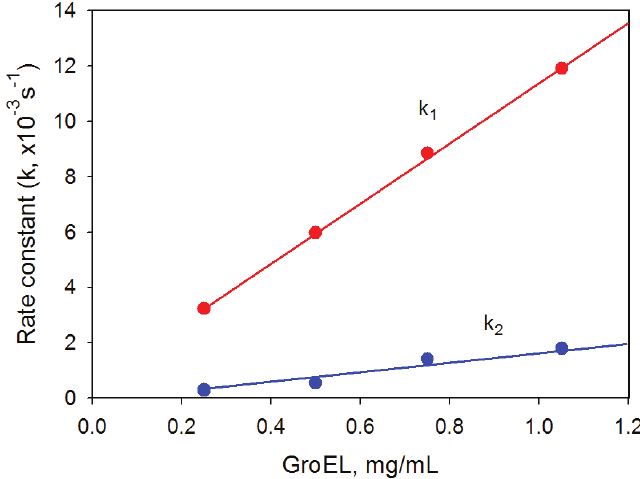
Figure 6. Dependence of the rate constants of GroEL oligomerization kinetic phases on the protein concentration. Buffer: 20 mM Tris-HCl, pH 7.5, 5 mM β ME, 100 mM (NH 0.4 M urea and 10 mM Mg-ATP.